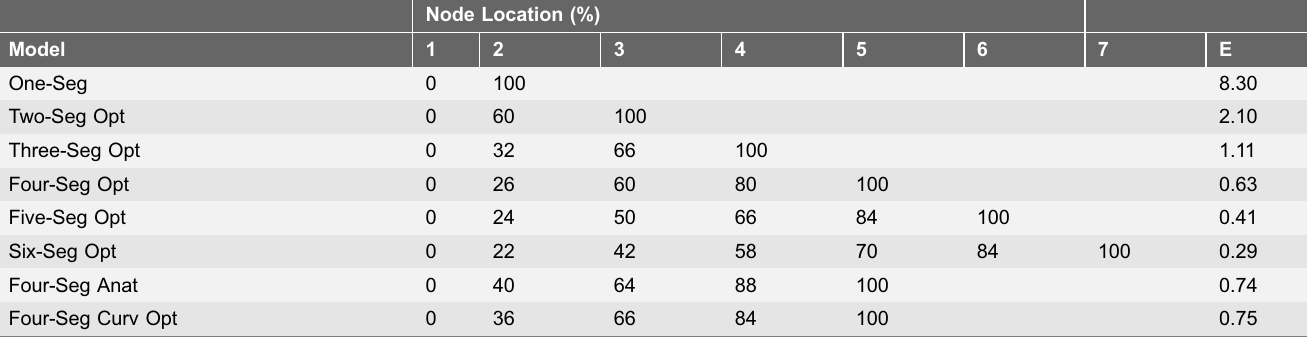
Table 1. Node Locations.